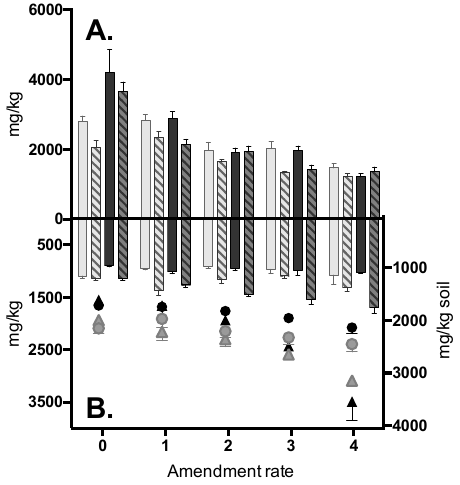
Figure 8. The calcium concentration of shoots ( A ) and roots ( B ) grown in Freeman (light grey) or Bernhill (dark grey) soils amended with KB- (solid) or wood- (cross- hatched) sourced biochars. The calcium of the soils (right axis, (B)) is also plotted for Freeman (light grey) or Bernhill (dark grey) soils amended with KB- (circle) or wood- (triangle) sourced biochars (Trippe 2015). Amendment rates are represented as 0–4, which correspond to rates of 0%, 3%, 6%, 16%, and 25% by volume for both biochars, 0%, 0.7%, 1.7%, 3.7%, and 8.6% by mass for wood biochar, and 0%, 0.4%, 1.2%, 2.5%, and 5.8% by mass for KB-sourced